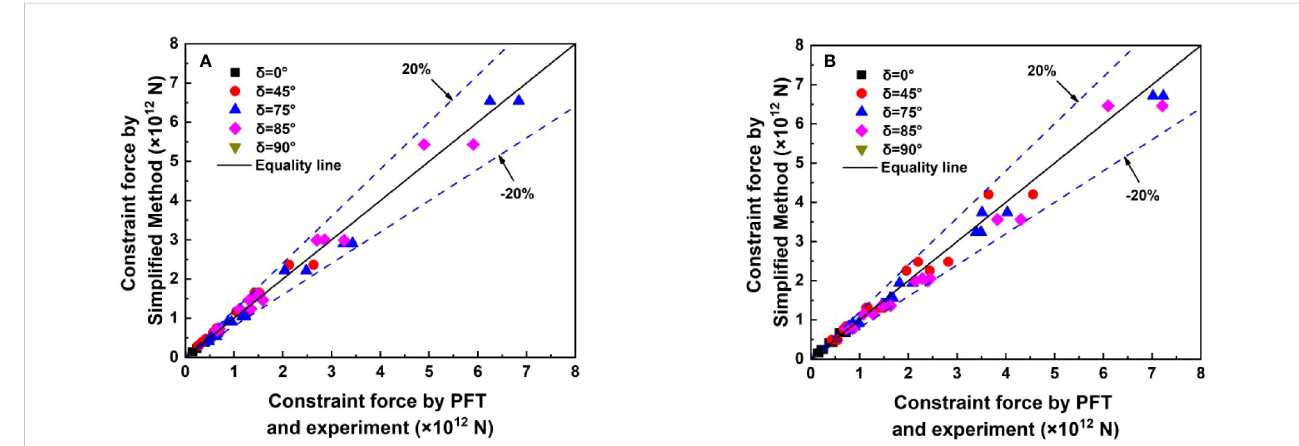
FIGURE 20 Comparison of the constraint force by simpli fi ed method versus those of PFT and experiment: (A) C 1 ; (B) C 3